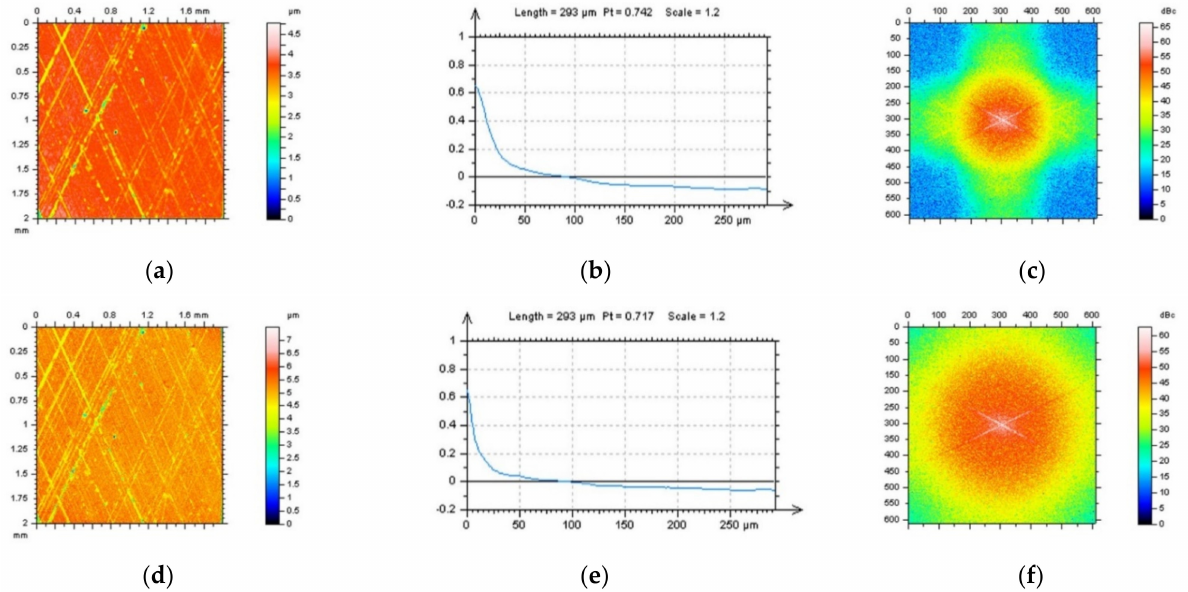
Figure 9. Contour map plots ( a , d ), centre-part of a profile ACFs received with a treatment trace technique ( b , e ) and FSs ( c , f ) from plateau-honed cylinder liner surface with raw measured data ( a – c ) and with added a high-frequency noise ( d – f